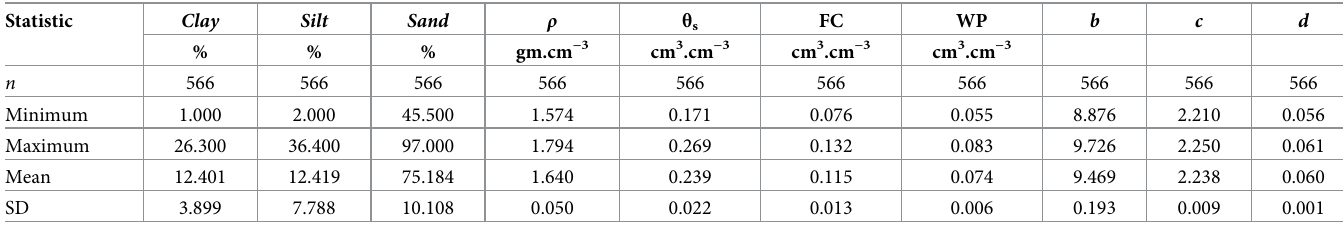
Table 1. Summary statistics of the soil properties in the study